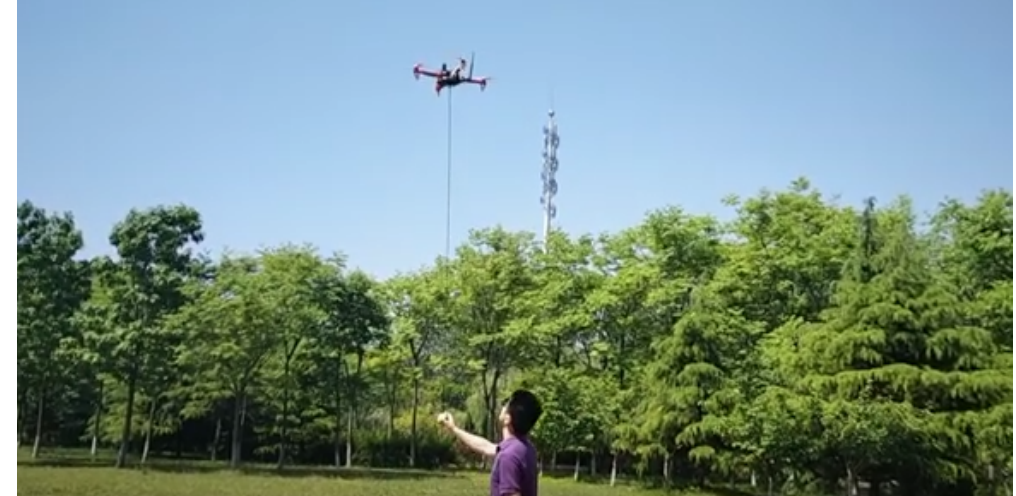
Figure 7. Uncertain disturbances were injected during the hovering tests.